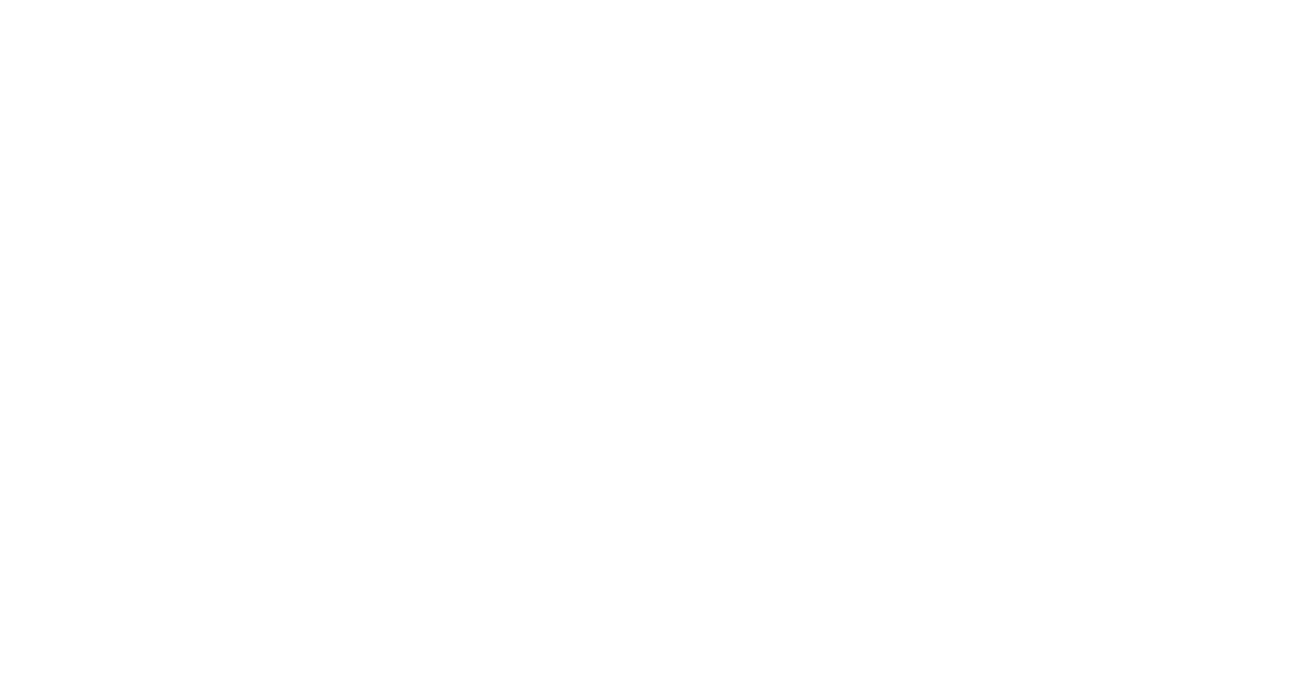
Frontiers in Pharmacology |